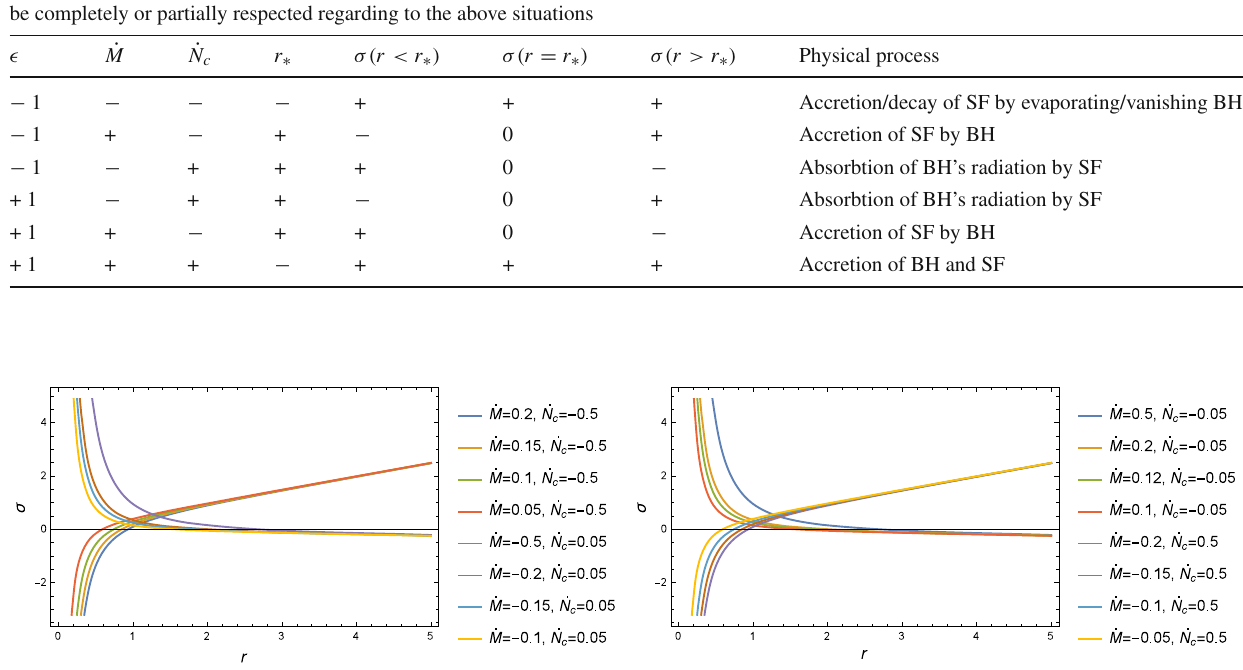
Table 6 BH and its surrounding cosmological field parameters for (cid:5) = ± 1. For the cosmological background, the positive energy condition may